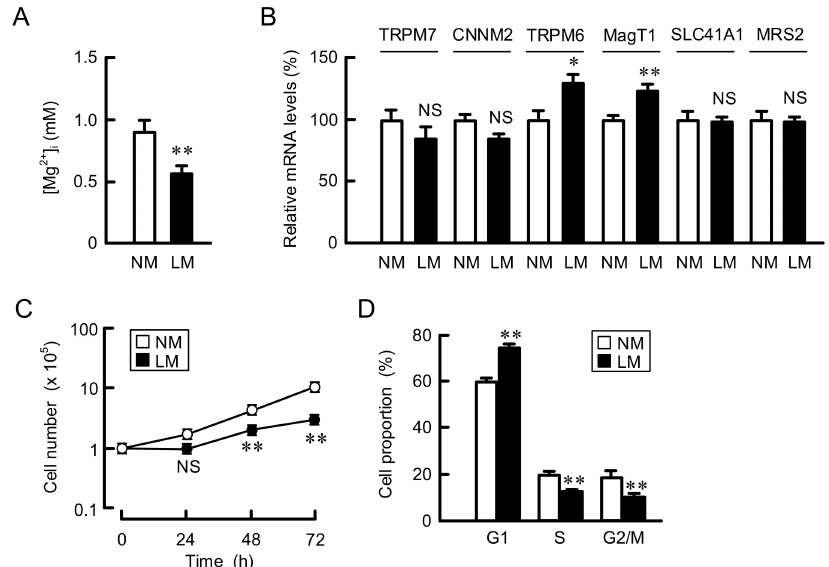
Figure 1. Inhibition of proliferation by LM in A549 cells. A549 cells were continuously cultured in the media containing normal 0.8 mM Mg 2+ (NM) or 0.5 mM Mg 2+ (LM). ( A ) [Mg 2+ ] i was measured using Mag-fura 2. ( B ) The mRNA levels of Mg 2+ transporters were examined by real-time PCR and represented in percentage to NM. ( C ) Cell number was counted at the time indicated. ( D ) The proportion of G1, S, and G2/M was measured using Muse Cell Analyzer. n = 3–4. ** p < 0.01 and * p < 0.05 compared with NM. NS p >